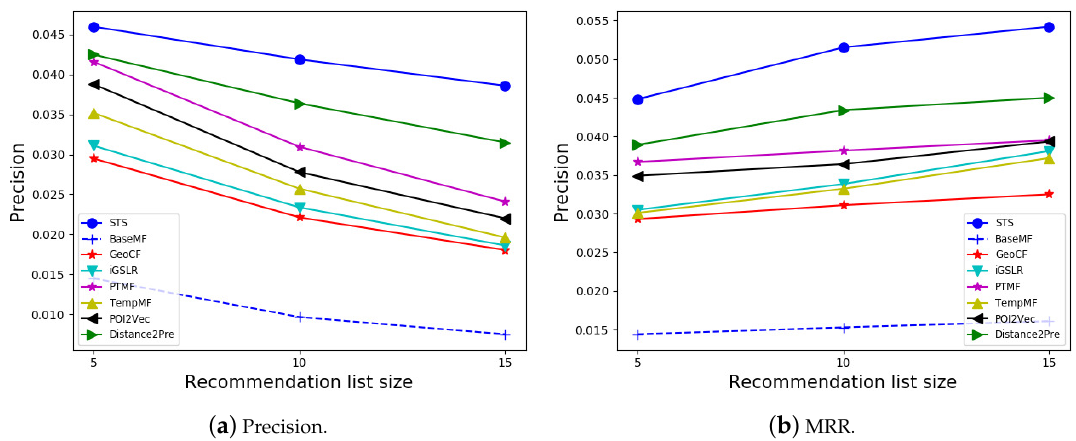
Figure 7. Performance comparison with varying recommendation list